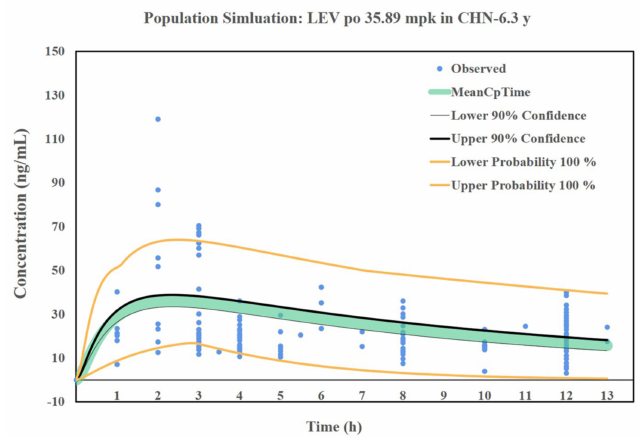
Figure 7. Prediction results of the oral LEV PBPK model in the Chinese pediatric population.